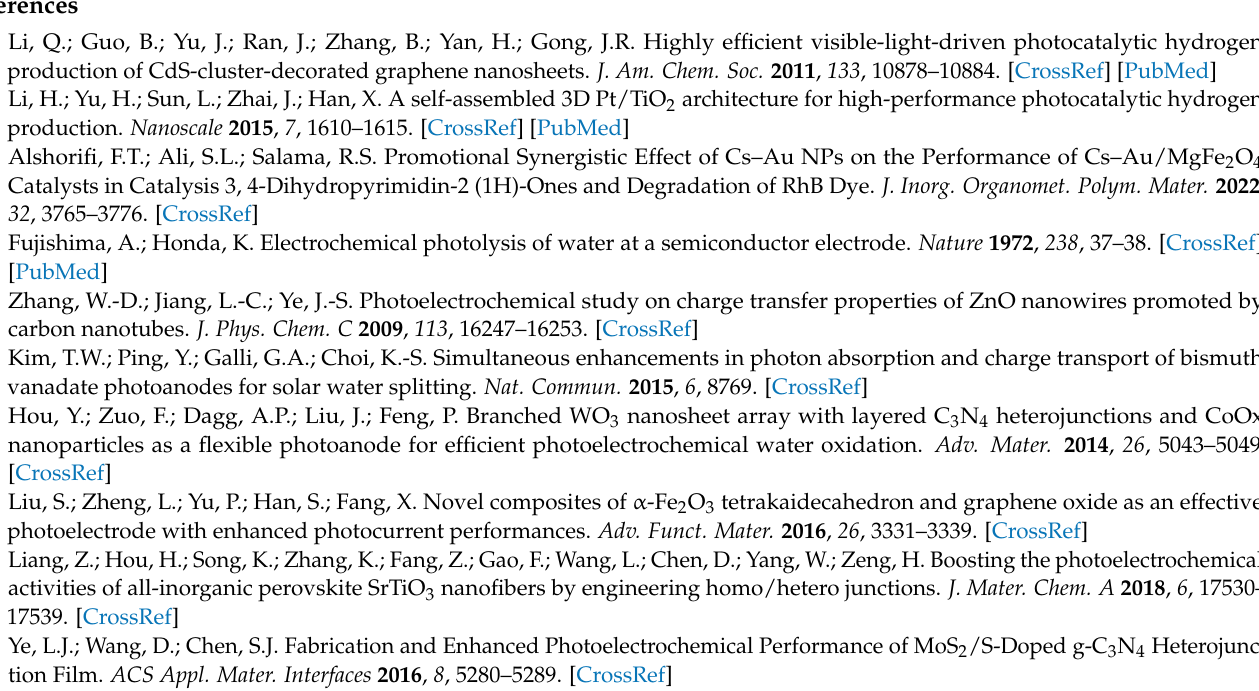
Figure S4. XPS O 1s spectra of TiO 2 @NCDs4h. Table S1. EIS Data of TiO 2 and NCD decorated TiO 2 photoanodes Table S2. The photocurrent densities of the TiO 2 and TiO 2 @NCDs